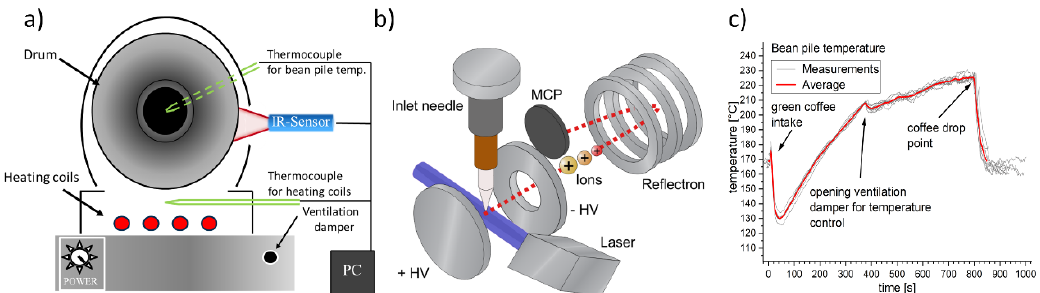
Figure 1. ( a ) Roast experiments for batch sizes of 100 g were conducted with a coffee drum roaster, which was electrically heated and equipped with a thermocouple to determine the bean pile temperature. ( b ) The instrumental setup consists of an Nd:YAG laser and non-linear optics to produce 266 nm UV-radiation or a KrF excimer laser providing 248 nm radiation for resonance-enhanced multi-photon ionization (REMPI). Ions were separated and detected by a reflectron time of flight mass spectrometer (TOFMS), which allows monitoring of the roasting off-gas composition down to subsecond time resolution. ( c ) The bean pile temperature shows a typical profile for drum roasters, including a temperature drop after filling and rebound. The second smaller temperature drop is caused by increased air flow from opening of the damper. The grey lines represent individual roasts of approximately 14 min.